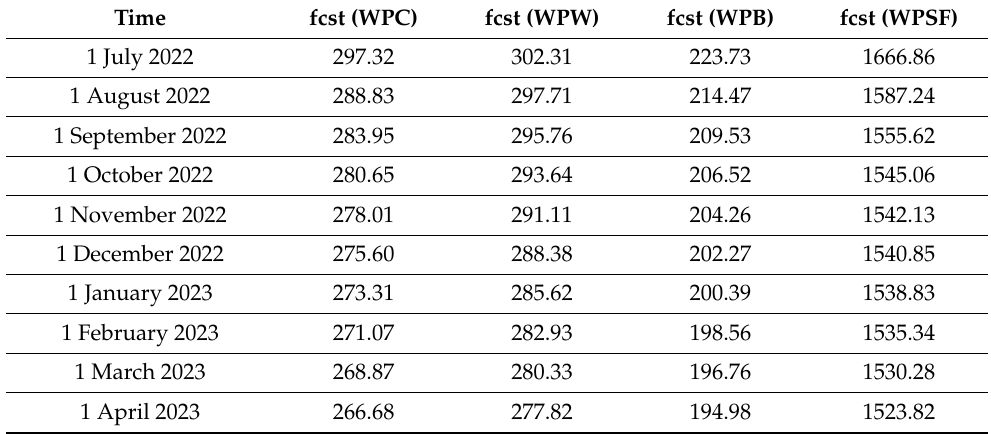
Table A1. Estimated predictions of the four variables used in our work, based on VAR (1) fanchart. Time